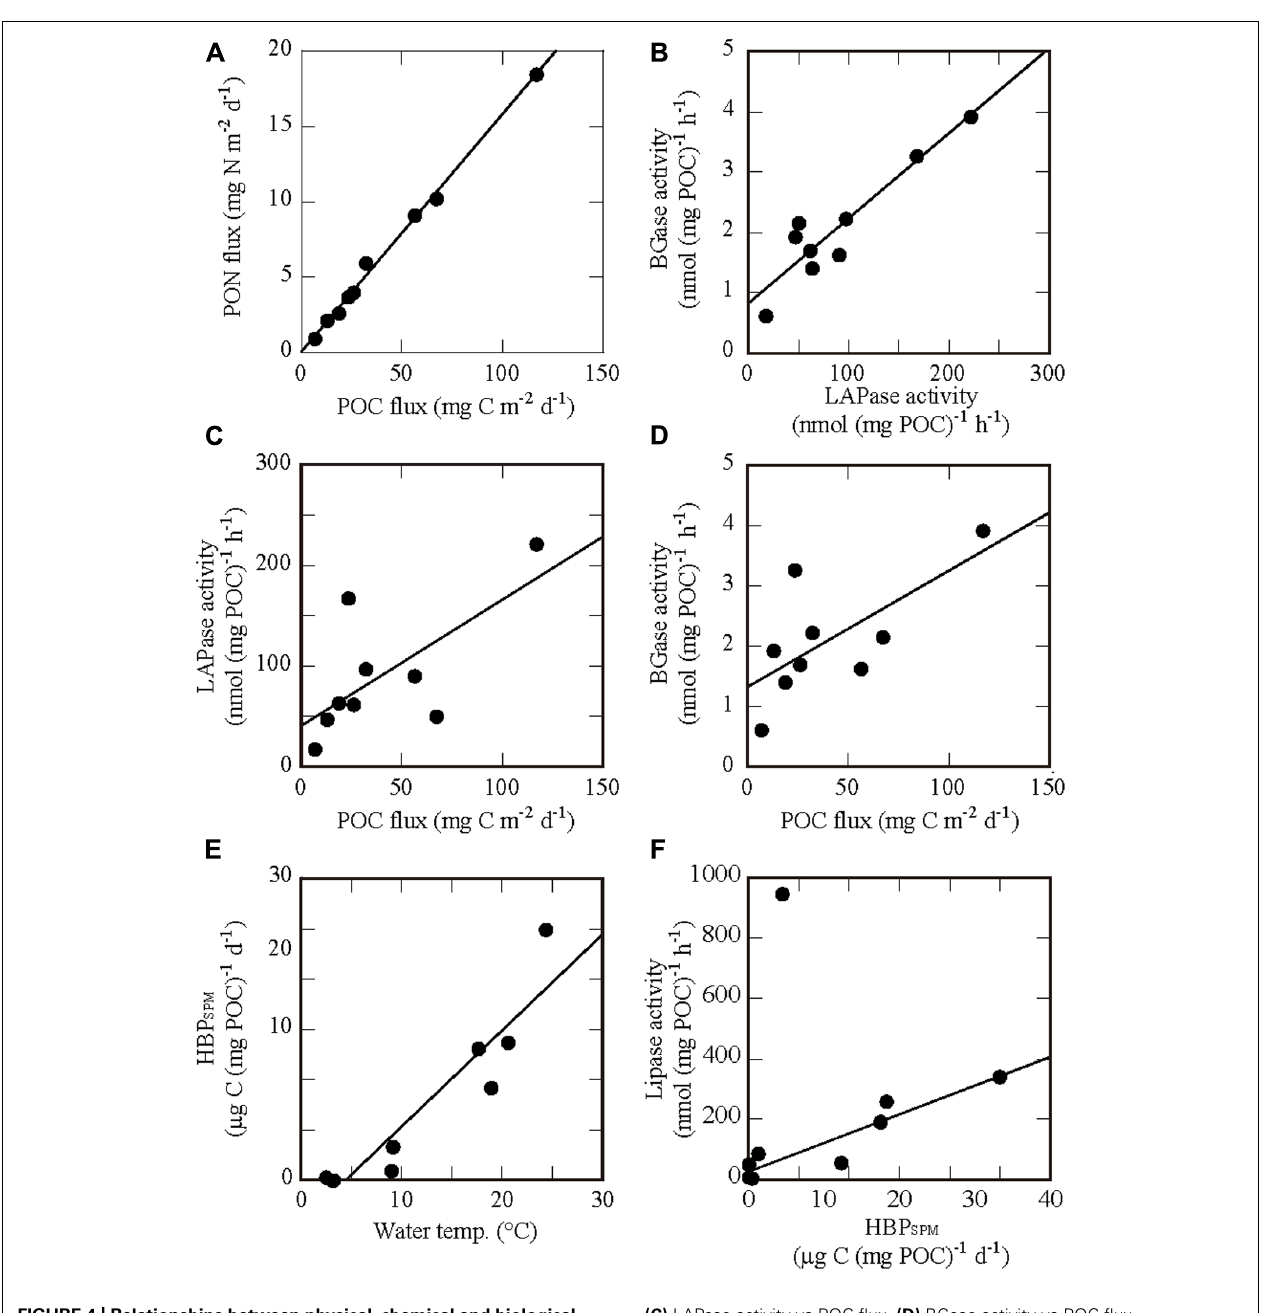
FIGURE 4 | Relationships between physical, chemical and biological variables in seawater and SPM for which significant correlations were found (Pearson product-moment correlation, P < 0.05). (A) PON flux vs POC flux, (B) BGase activity vs LAPase activity,